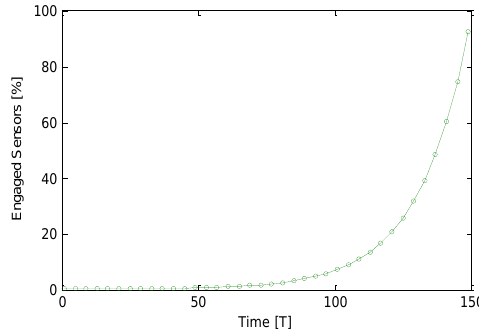
Figure 10. Engaged sensor % with in GS-IoT.